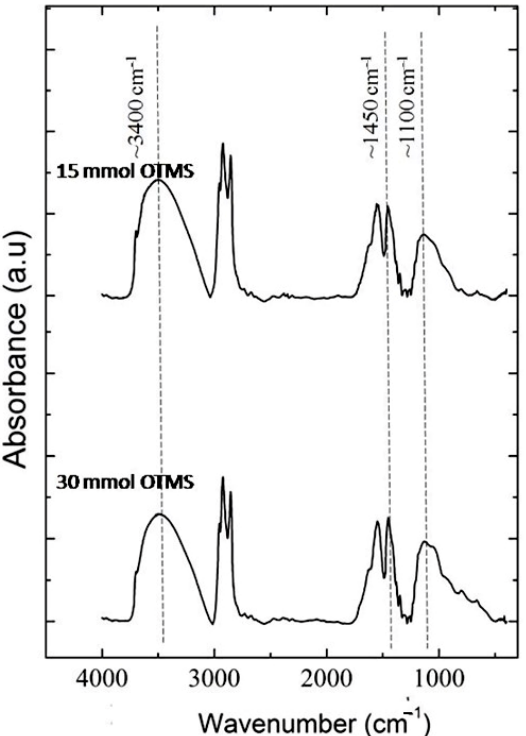
Figure 7. The FTIR images of SiO 2 -TiO 2 -OTMS coatings, prepared with various compositions of OTMS.